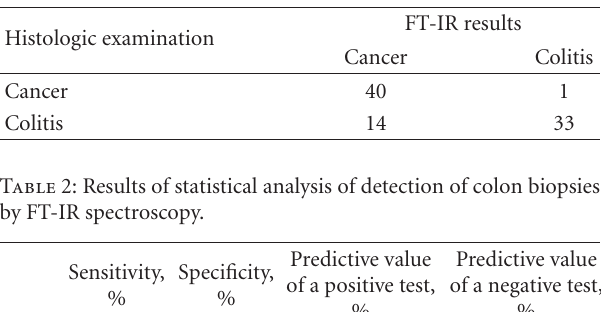
Figure 1: Mean FT-IR spectra of colon biopsies. Trace (A) , colitis; Trace (B) , colon cancer.